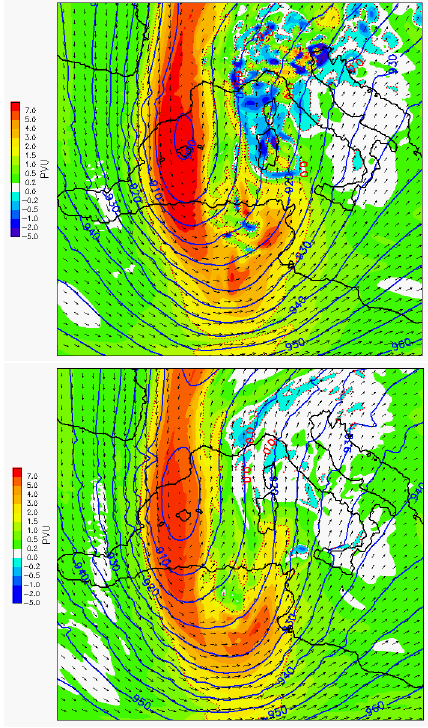
Fig. 8. 300-hPa PV, GPH, and wind at 0000 UTC 11 December 2008. Top: QBOLAM. Bottom: BOLAM 2007. Fig. 8. 300-hPaPV, GPH, and wind at 00:00UTC 11 Decem- ber 2008. Top: QBOLAM; bottom: BOLAM